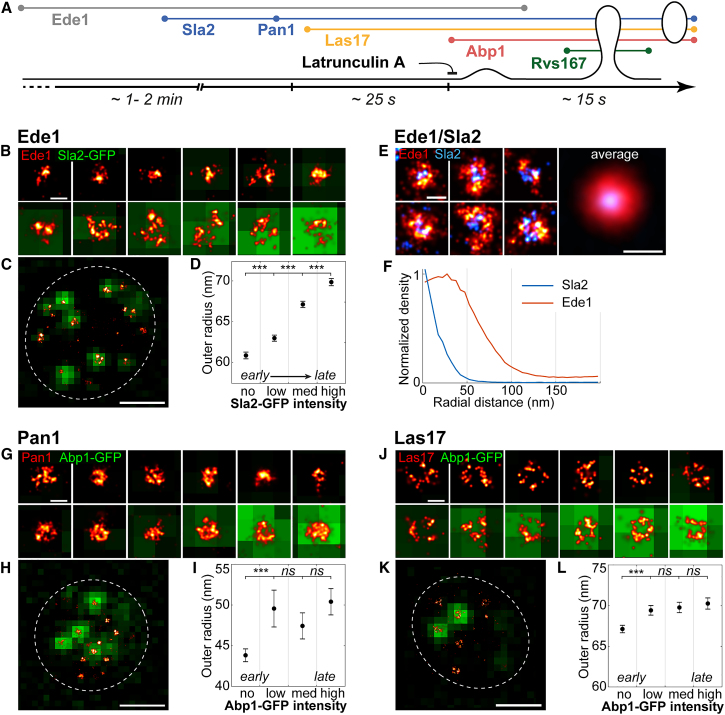
Structural Rearrangements of Key Proteins during Endocytosis(A) Strategy: Staging of endocytosis by combining superresolution imaging with diffraction-limited imaging of Sla2, Abp1, and Rvs167, which each label specific phases of endocytosis. Latrunculin A arrests endocytosis before membrane bending begins (see Figure 2H).(B and C) Ede1 in superresolution overlaid on diffraction-limited images of Sla2-GFP at individual sites (B) and in a cell overview (C).(D) Outer radii of Ede1 sites for no, low, medium, and high Sla2-GFP intensities, as proxy for early to late time points (mean ± SEM; nno = 2514; nlow = nmed = nhigh = 2,634).(E) Dual-color superresolution images of Ede1-mMaple and Sla2-GFP αGFP-nanobody-AF647.Representative individual sites and the average distribution from 267 sites are shown.(F) Corresponding radial profiles.(G–I) Like (B)–(D), but for Pan1 in superresolution and Abp1-GFP as timing marker. (nno = 494; nlow = nmed = nhigh = 98.)(J–L) Like (B)–(D), but for Las17 in superresolution and Abp1-GFP as timing marker. (nno = 2,550; nlow = nmed = nhigh = 1,595.)Scale bars represent 100 nm (B, E, G, and J) and 1 μm (C, H, and K). ∗∗∗p < 0.001 from Wilcoxon rank-sum test.See Figure S5 for radial profiles and Table S2 for data.